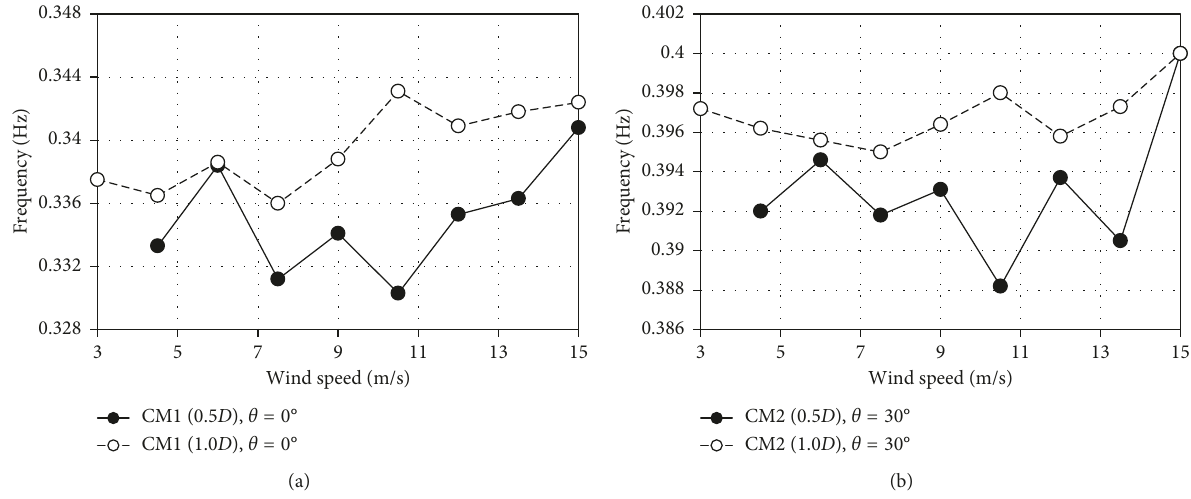
Figure 12: Vertical vibrations frequencies for models with 0.5D and 1.0D ice accretion: (a) CM1 ( θ � 0 ° ); (b) CM2 ( θ � 30 ° ).